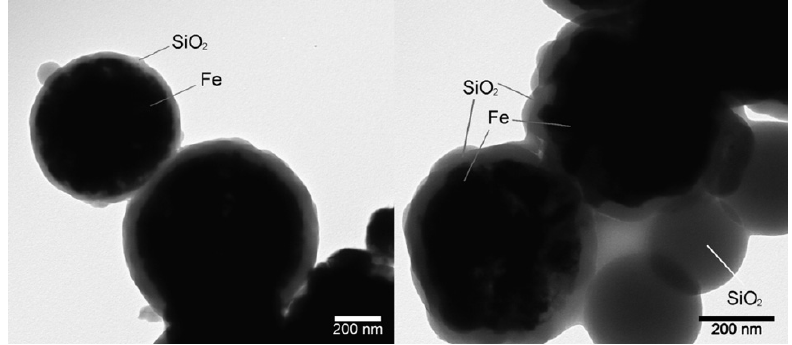
Figure 5. Transmission electron images of the “Fe@SiO 2 ” particles.